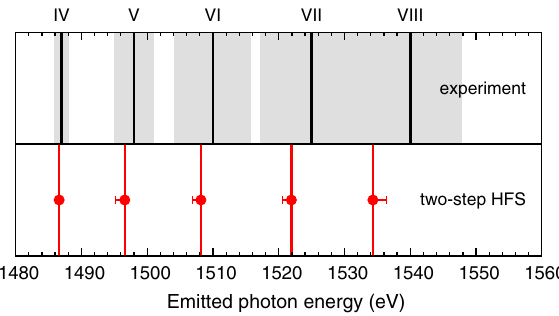
FIG. 8. K α transition energies of aluminum ions obtained with the two-step HFS model. They are compared to the experimental data taken from Ref. [22]. The gray areas indicate the FWHM from